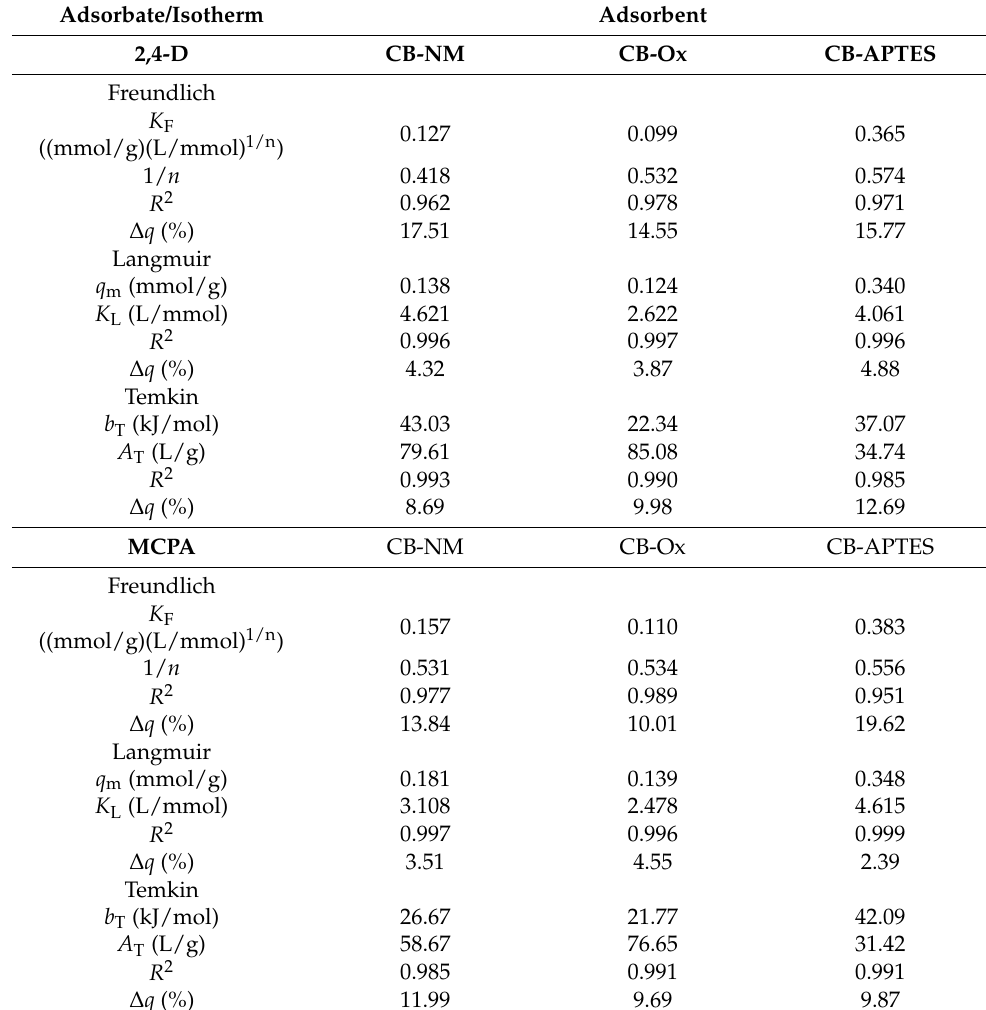
Table 5. The Freundlich, Langmuir, and Temkin isotherm constants for adsorption of 2,4-D and MCPA on carbon black samples.